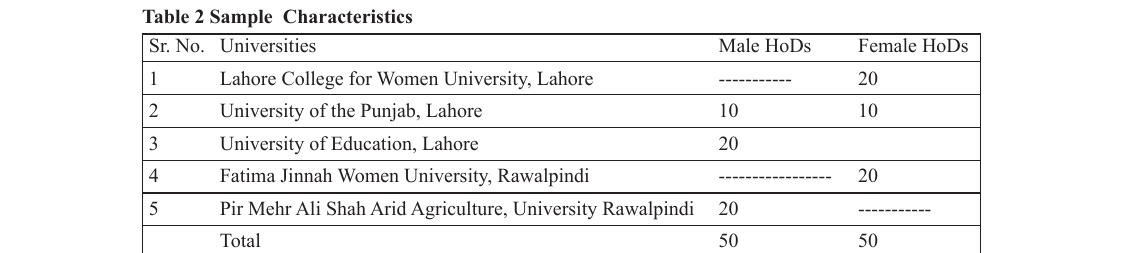
Table 2 Sample Characteristics